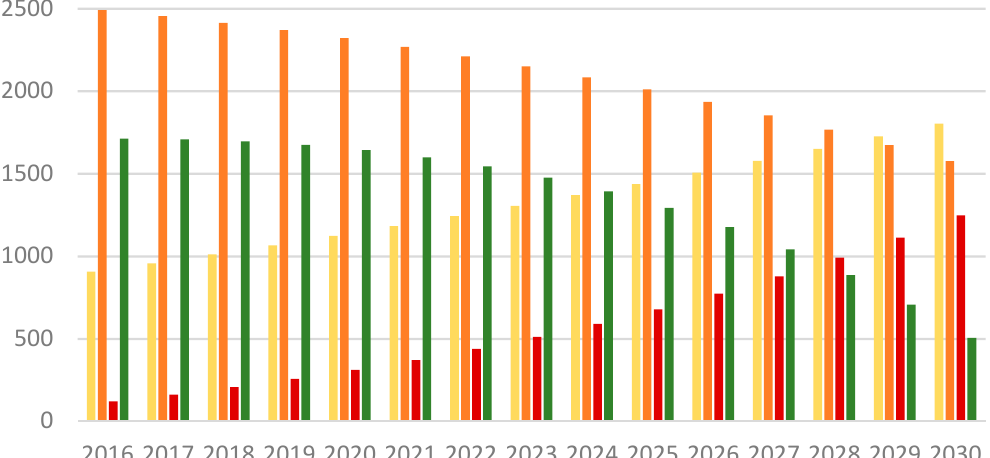
Figure 12. Firewood demand in the rural residential area according to the annual introduction of improved stoves until 2030. (Thousands of Barrel of Oil Equivalent per year).